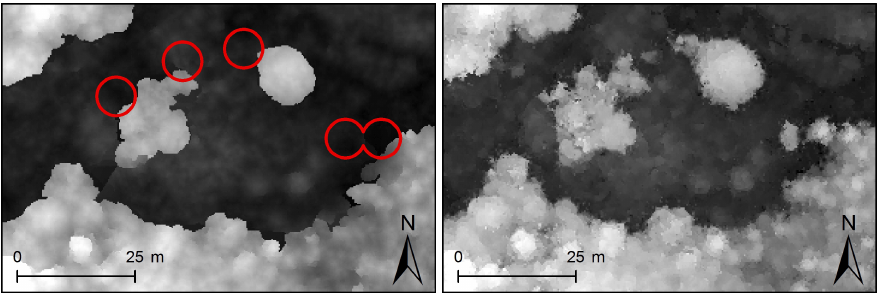
Figure 3. Comparison of two matching strategies: Malt ( Left ) and MICMAC ( Right ). Red circles highlight the positions of trees that have not been reconstructed with Malt. The optimal photo-DSM used, further, is the DSM produced with MICMAC.